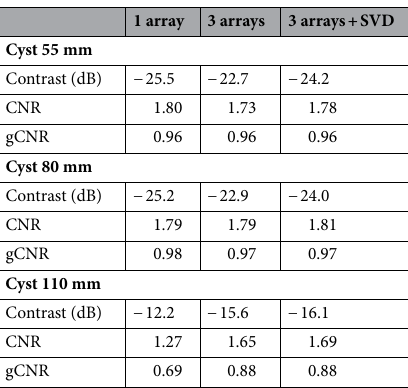
Table 1. Evaluation of contrast ratio (CR), contrast-to-noise ratio (CNR) and generalized contrast-to-noise ratio (gCNR) after imaging with the central array only or with all three arrays on the commercial phantom. Quantification is done on cyst-like structures at depths of 55, 80 and 110 mm for 91 PWs (− 30° to